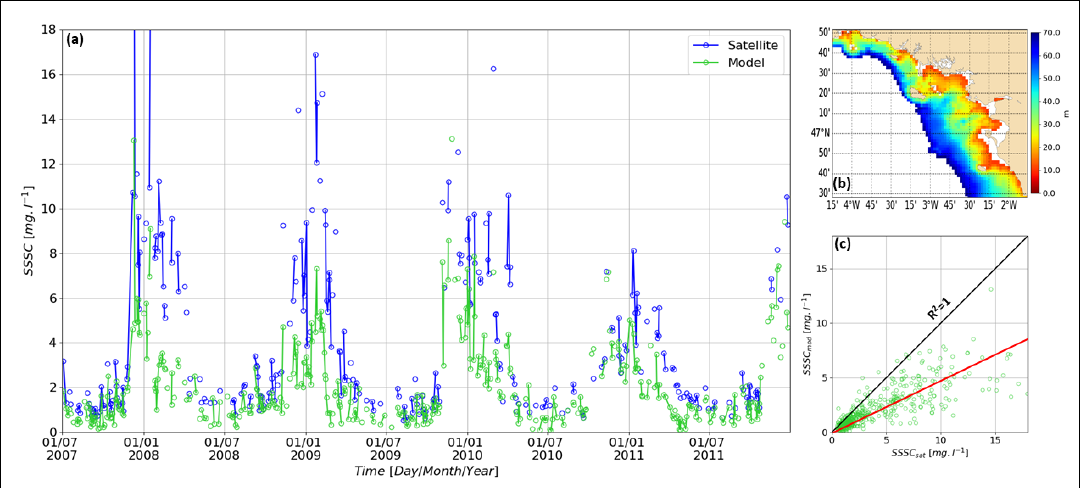
Figure 2. Comparison of daily satellite SSSC [29] (SSSC sat ) with model results (SSSC mod ). ( a ) SSSC time series in mg/L (constrained by the daily frequency of satellite observations) along the 2007–2011 period, averaged over the 10–70 m bathymetric range of the area of interest plotted in ( b ). Time series on ( a ) are masked when the cloud cover is higher than 90% over the area of interest. ( c ) Correlations between modeled and observed SSSC, where continuous and red line refer to model underestimations (with respect to observations) by a factor of